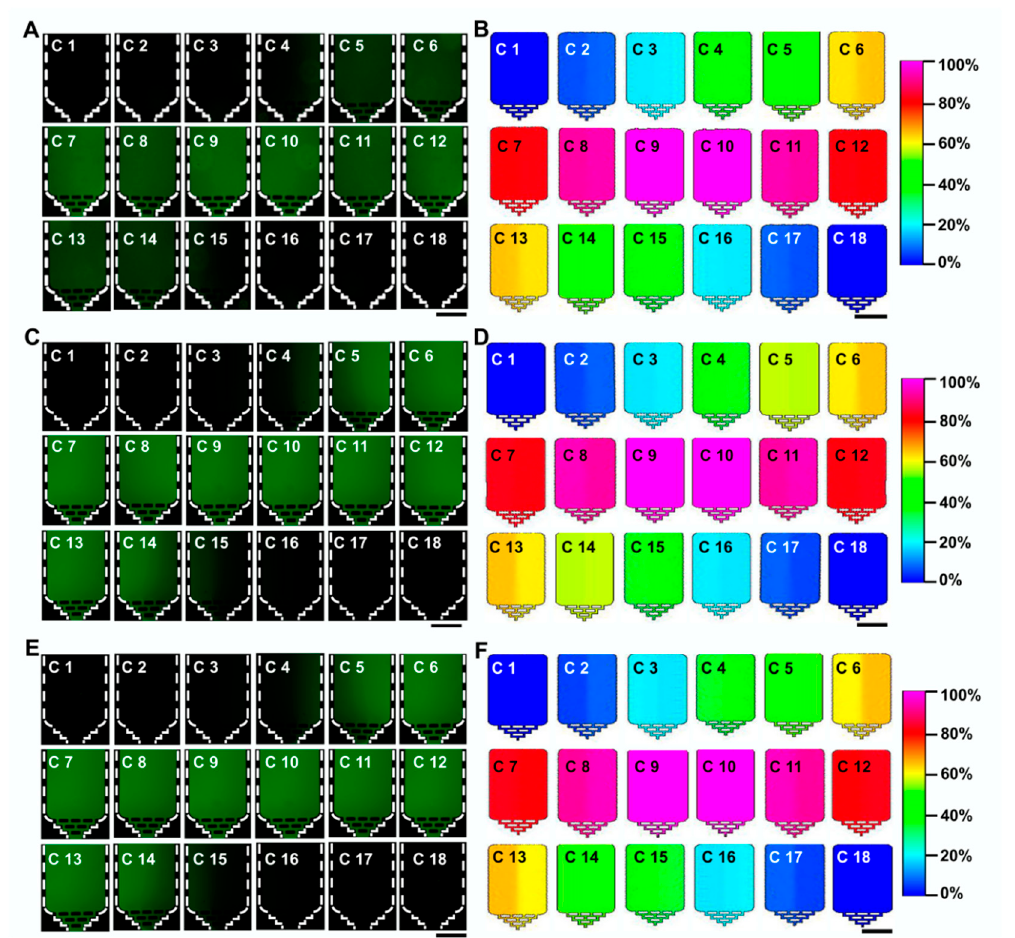
Figure 3. Formation of concentration gradients in 18 microchambers under different flow conditions. ( A , C , E ) The mixed states of fluorescein dye at different flow rates of 10 μ L·min − 1 ( A ), 20 μ L·min − 1 ( C ), and 50 μ L·min − 1 ( E ). Every two adjacent white dotted lines delineate the boundary of the microchip. ( B , D , F ) Computer simulation effect at the flow rates of 10 μ L·min − 1 ( B ), 20 μ L·min − 1 ( D ), and 50 μ L·min − 1 ( F ). Scale bar, 500 μ m.